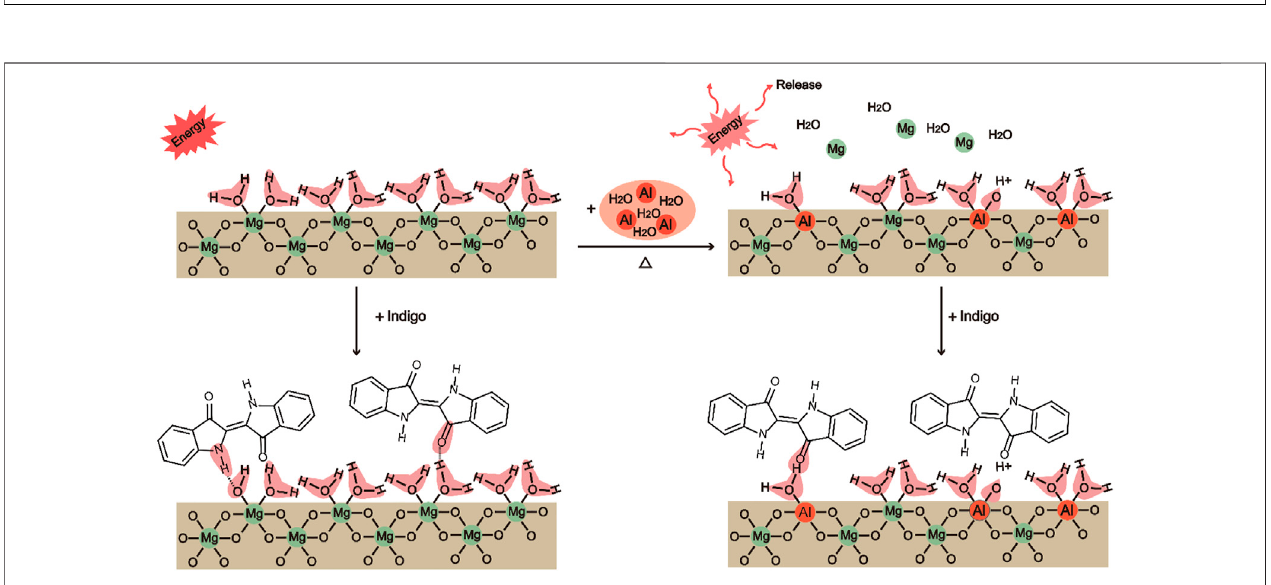
FIGURE 9 | The mechanism of the substitution of Al 3+ for Mg 2+ located at the octahedron in sepiolite and the bonding of Sep, Al-Sep with Id (executed in (200) plane).